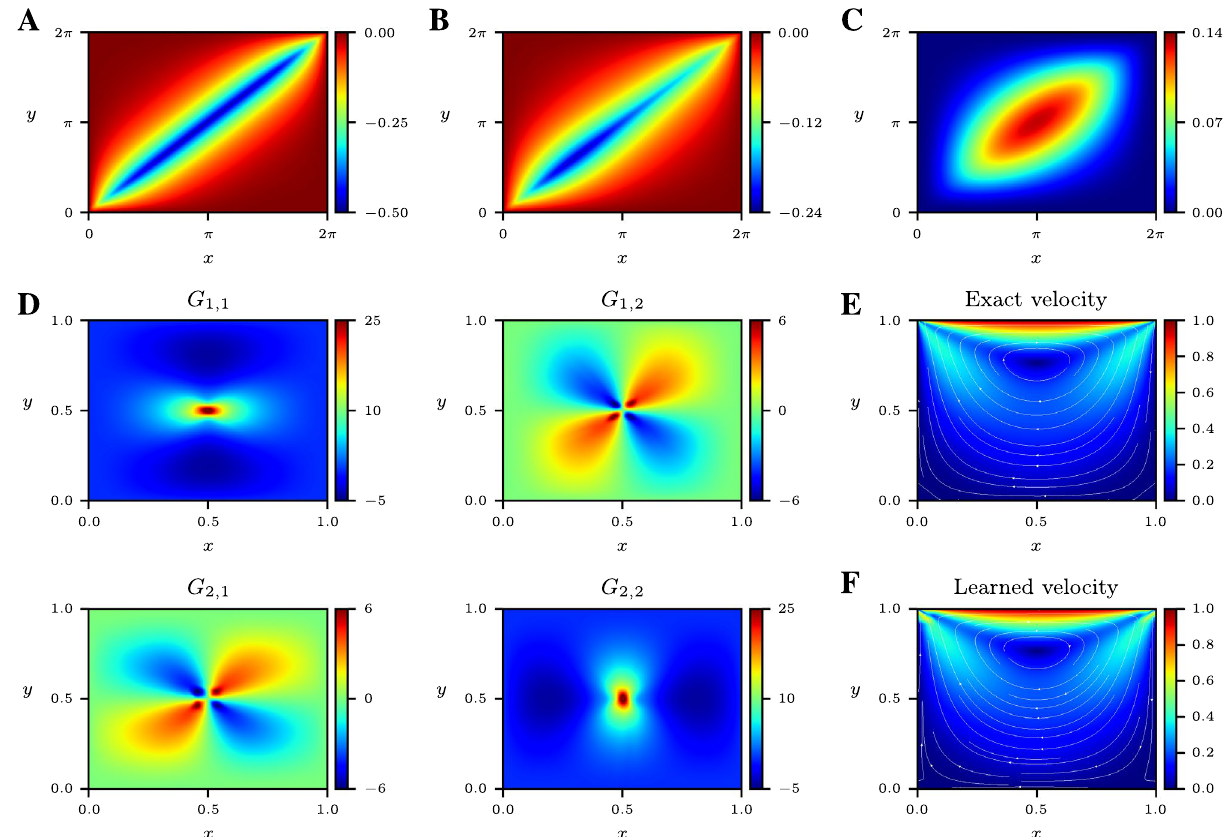
Figure 4. Linearized models and Stokes flow. ( A–C ) Green’s functions of three differential operators: Helmholtz, Sturm–Liouville, and biharmonic, with cubic nonlinearity. ( D ) Matrix of Green’s functions of a two-dimensional Stokes flow in a lid-driven cavity, evaluated at a two-dimensional slice. Velocity magnitude and streamlines of the exact ( E ) and learned ( F ) homogeneous solution to the Stokes equations with zero applied body